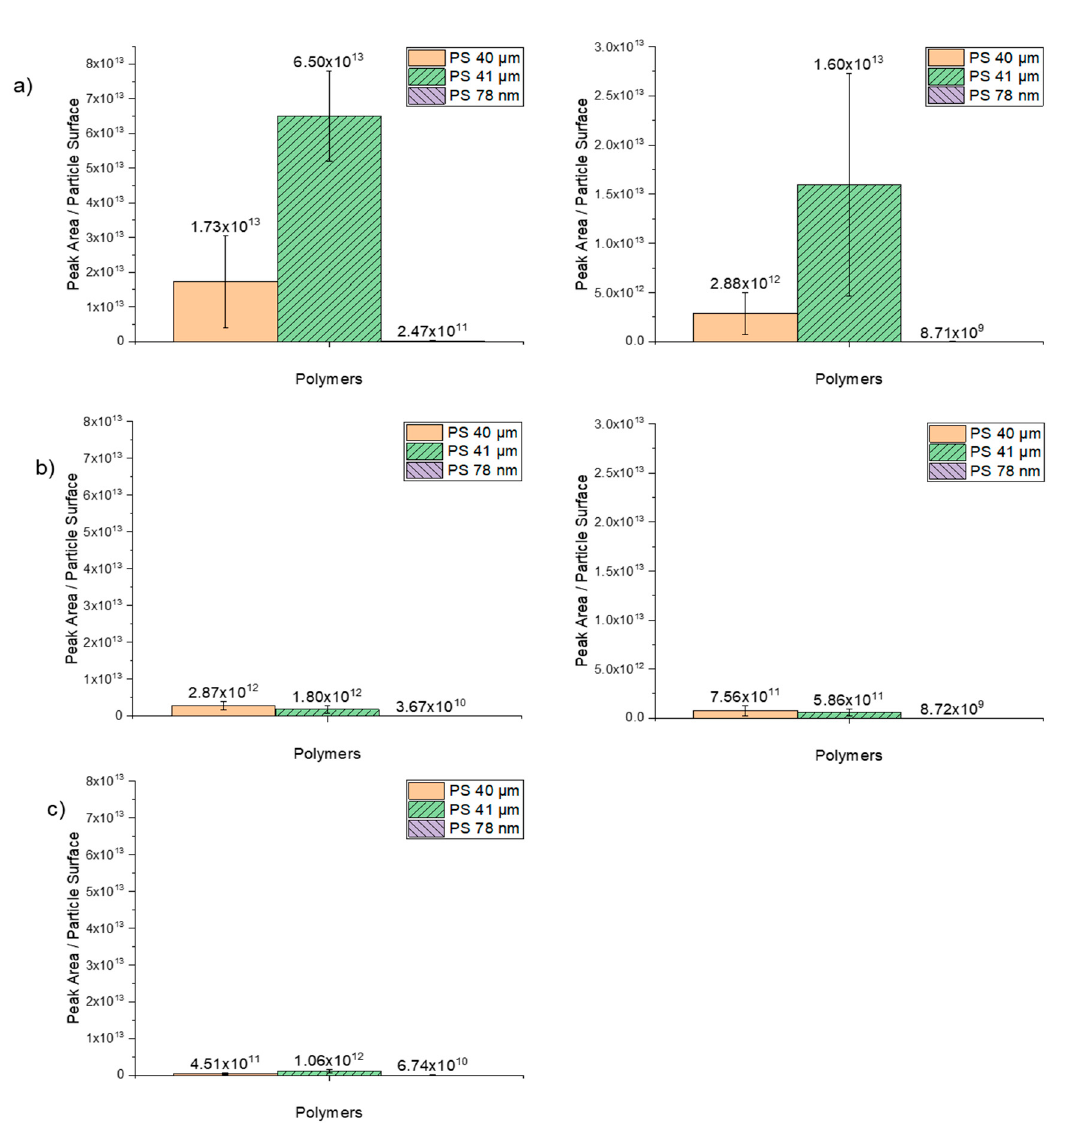
Figure 8. Sorption of the selected trace substances as a function of peak area / particle surface on the spherical PS particles in sizes 40 µ m, 41 µ m and 78 nm. ( a ) 1 µ g / mL (right) and 0.1 µ g / mL (left) phenanthrene, ( b ) 1 µ g / mL (right) and 0.1 µ g / mL (left) α -cypermethrin, ( c ) 1 µ g / mL (right) triclosan.